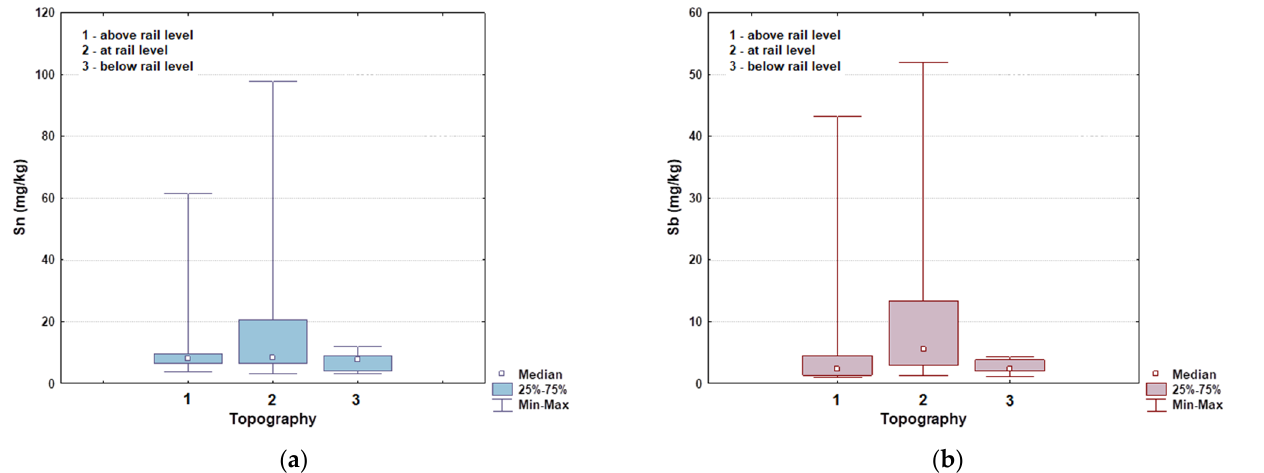
Figure 7. Dependence of concentration of Sn ( a ) and Sb ( b ) in soil and site topography (boxplots were obtained by Kruskal–Wallis ANOVA followed by a pairwise comparison using Dunn’s method, with the significance level set at p < 0.05).